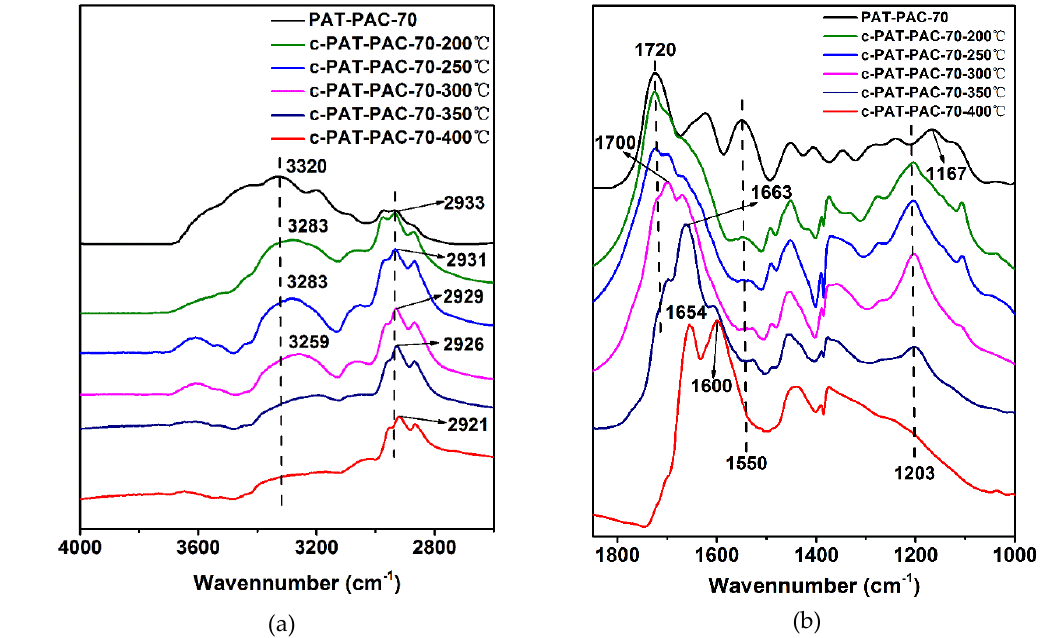
Figure 3. FTIR of the chemical structure changes during the carbonization: (a) the spectra within the spectral ranges of 4000–2600 cm − 1 and (b) the spectra within the spectral ranges of 1850–1000 cm − 1